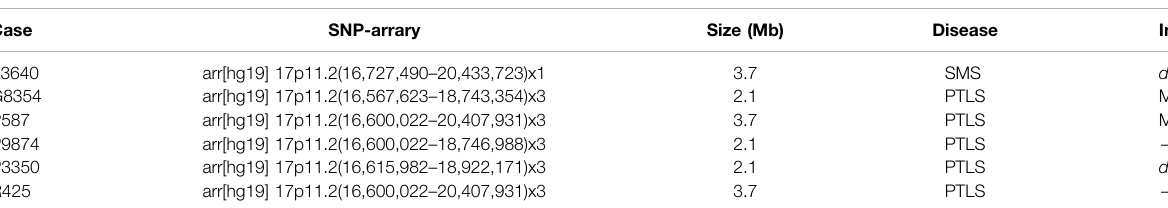
SMS, Smith-magenis syndrome; PTLS, Potocki-lupski syndrome.